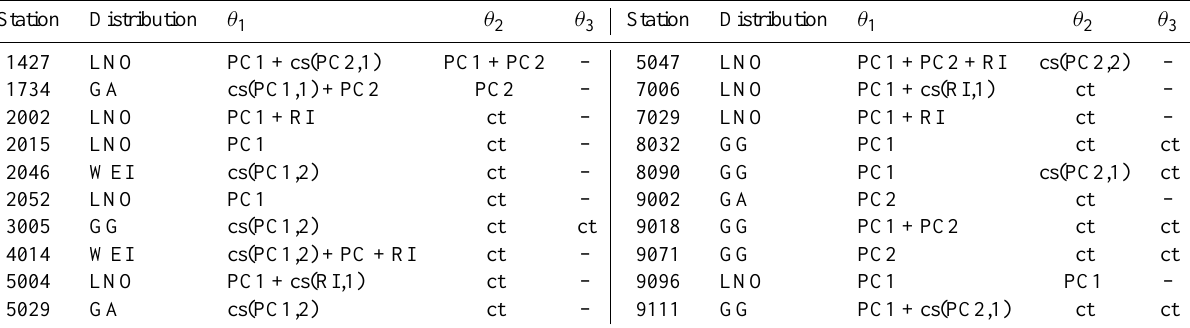
Table 5. Summary for the fitted models type 2, with the indication of the selected distribution, the significant covariates (PCs and/or RI), and the type of dependence with the distribution parameters: cs( · ) indicates the dependence is via the cubic splines with the indicated degree of freedom; without cs( · ) means linear dependence; and ct refers to a parameter that is independent of the covariates (i.e.